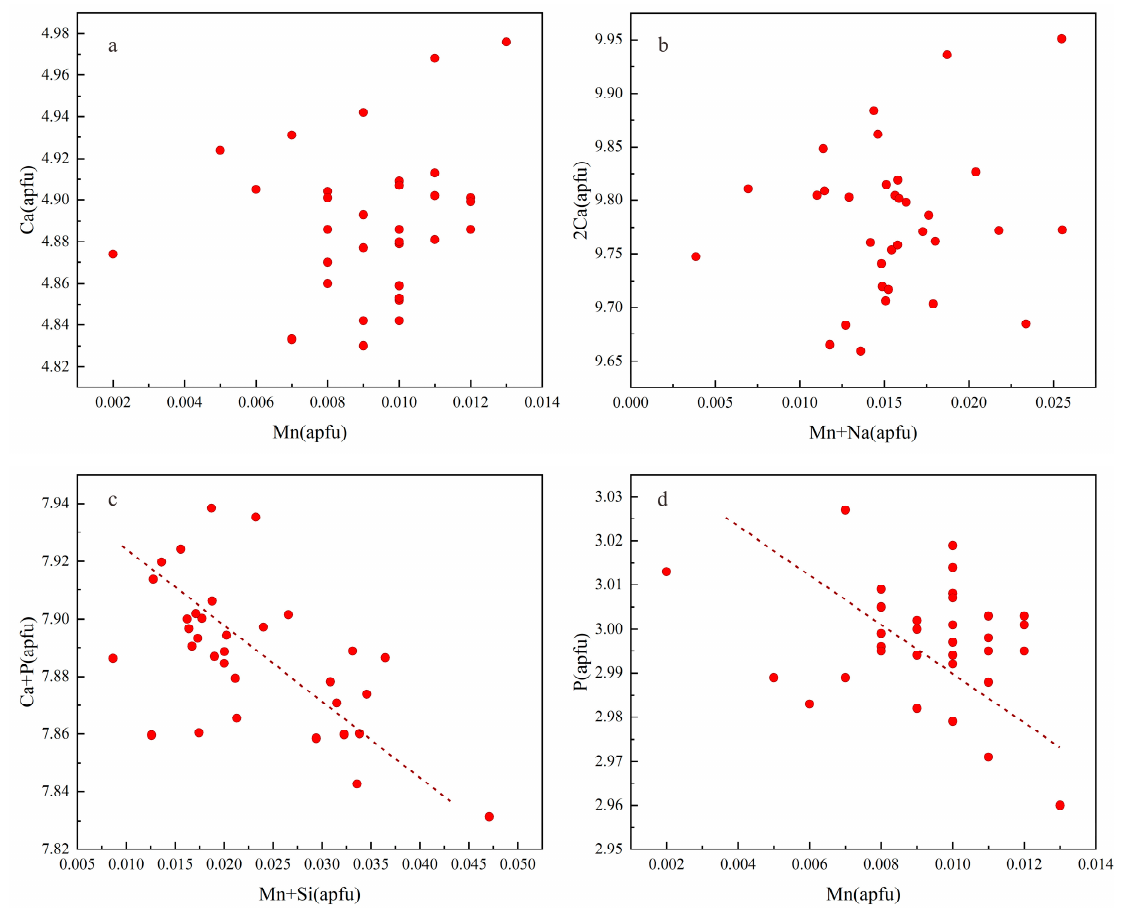
Figure 9. Covariant relations of cations in apatites from the dacite. ( a ) Ca versus Mn; ( b ) 2Ca versus Mn + Na; ( c ) Ca + P versus Mn + Si; ( d ) P versus